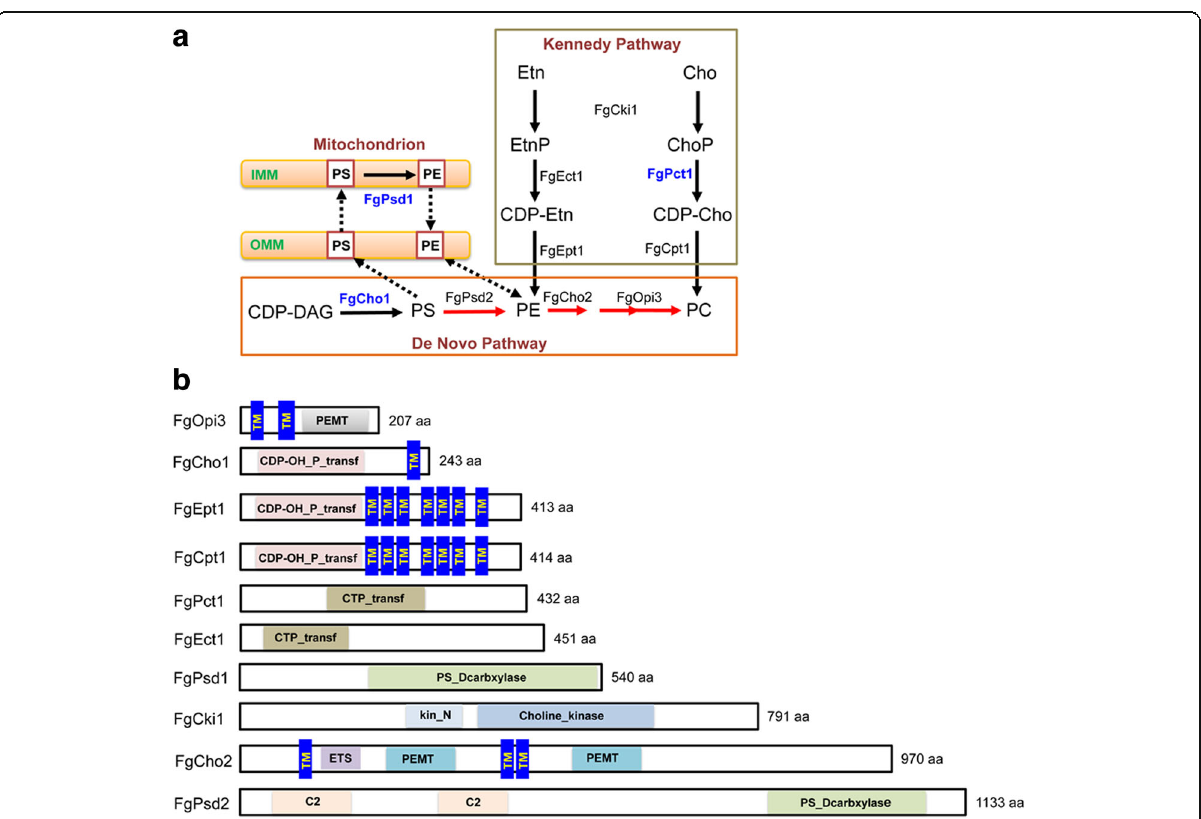
Fig. 1 Identification of phospholipid biosynthetic genes in Fusarium graminearum . a Schematic outline of phospholipid biosynthesis pathways in F. graminearum . Two alternative pathways of phospholipid biosynthesis, the de novo pathway and the Kennedy pathway, exist in this fungus. The essential enzymes are marked in blue. The major routes for PE and PC biosynthesis are indicated by the red arrows. FgPsd1 is predicted to be localized on the inner mitochondrial membrane (IMM). b Predicted conserved domains in the phospholipid biosynthetic enzymes of F. graminearum . OMM, outer mitochondrial membrane; CDP-DAG, cytidyldiphosphate diacylglycerol; PS, phosphatidylserine; PE, phosphatidylethanolamine; PC, phosphatidylcholine; Etn, ethanolamine; EtnP, ethanolamine phosphate; CDP-Etn, cytidyldiphosphate-ethanolamine; Cho, choline; ChoP, choline phosphate; CDP-Cho, cytidinediphosphocholine; TM, transmembrane; PEMT, phospholipid methyltransferase; CDP-OH_P_transf, CDP-alcohol phosphatidyltransferase; Ctp_transf, cytidylyltransferase; PS_Dcarbxylase, phosphatidylserine decarboxylase-related; kin_N, choline kinase N terminus; ETS, erythroblast transformation specific domain; C2, protein kinase C conserved region